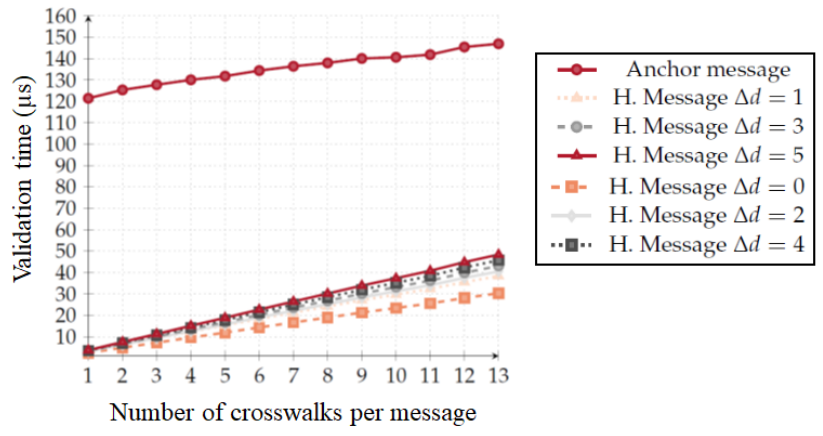
Figure 9. Evolution of validation time x number of